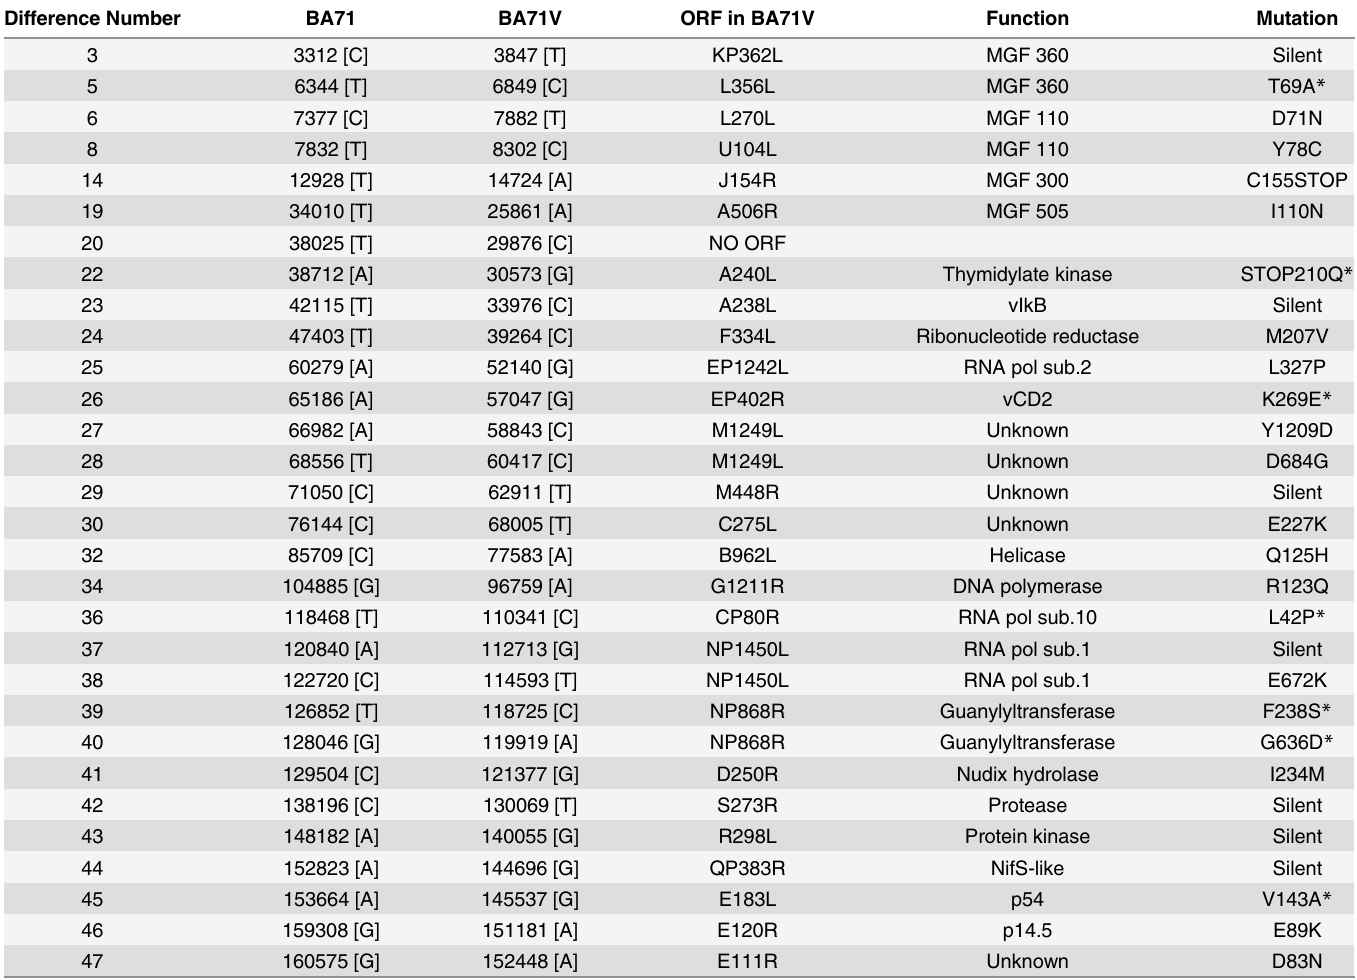
Table 5. Differences between BA71 and BA71V: Point